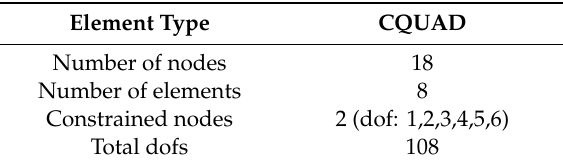
Table 1. FEM mean Features.